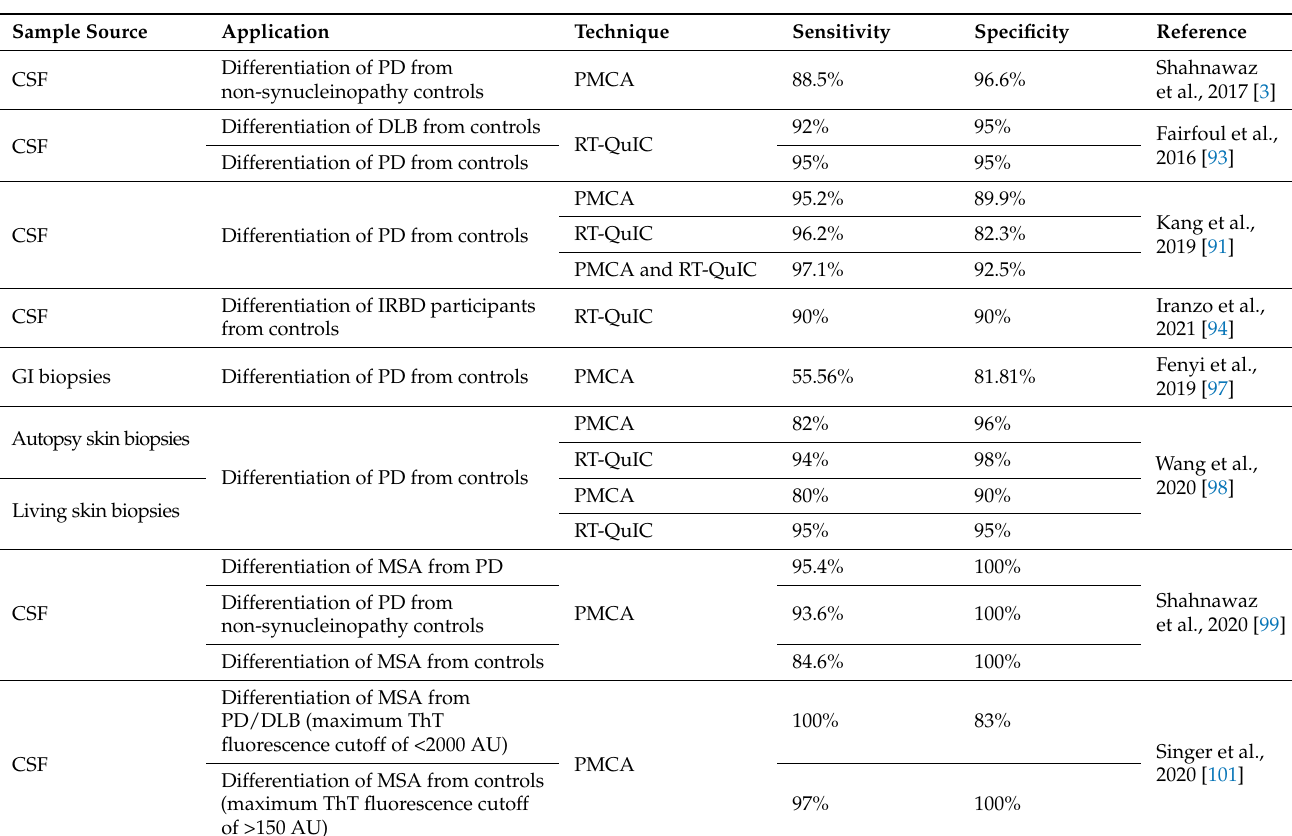
Table 1. Sensitivities and Specificities of Strain-Amplification Assays . The sensitivities and speci- ficities from the studies described are listed in order of discussion, and categorized by sample source, application, and strain amplification